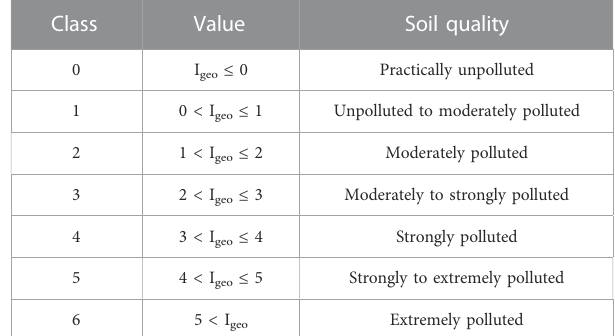
TABLE 1 Seven classes comprising the geo-accumulation